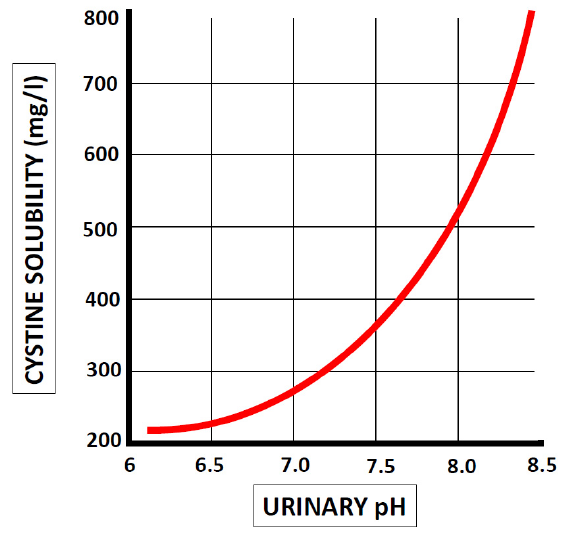
Figure 1. Solubility of cystine at different urinary pH values [34,35].